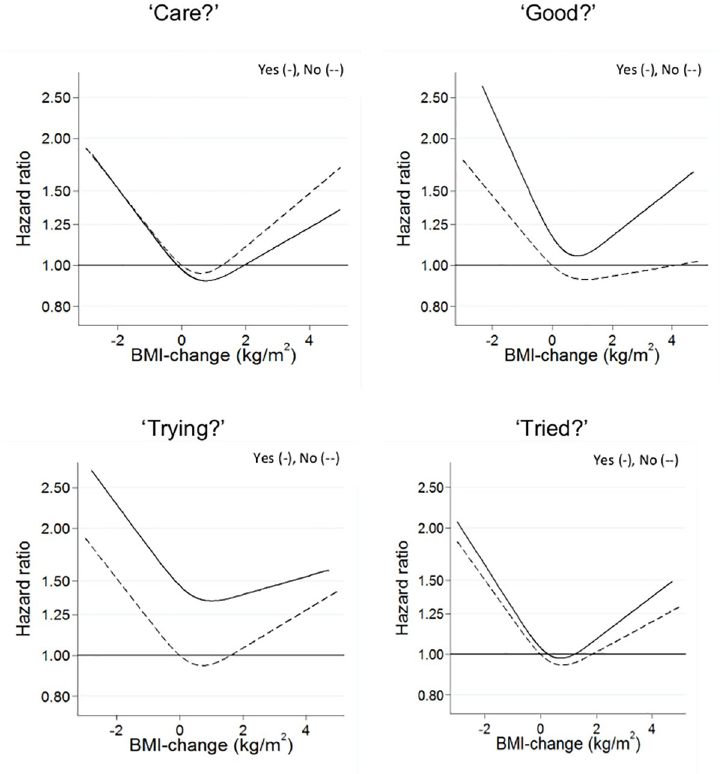
Fig 2. Body weight control, changes in body weight and all-cause mortality in relation to body weight control questions in the normal weight group; Yes (-), No (--).